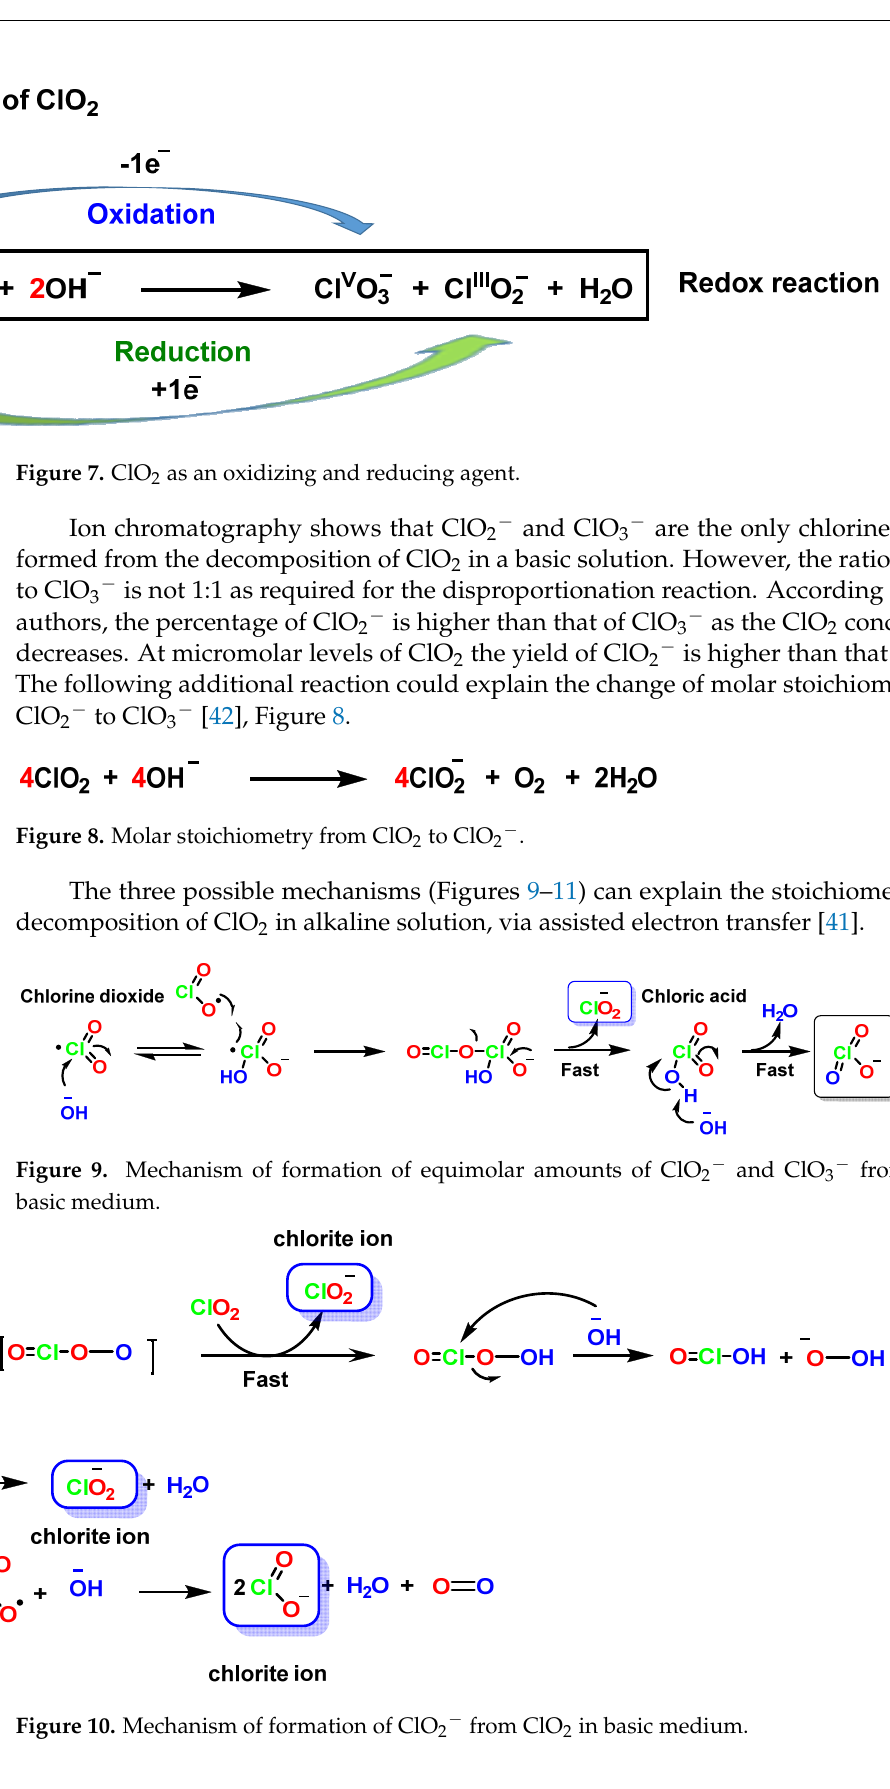
Figure 11. Mechanism of the formation of equimolar amounts of ClO 2 − and ClO 3 − from Cl 2 O 4 in basic medium. The distribution of chlorine dioxide decomposition products in a basic solution changes as the ClO 2 concentration decreases. While disproportionation reactions giving equal amounts of ClO 2 − and ClO 3 − dominate the stoichiometry at millimolar or higher ClO 2 levels, the ratio of ClO 2 − to ClO 3 − formed increases significantly at micromolar levels of ClO 2 [42]. The kinetic evidence shows three concurrent pathways that show a first order de ‐ pendence on [OH − ] but have a variable order on [ClO 2 ]. Pathway 1 is a disproportionation reaction that is first order in [ClO 2 ], Figure 12. Figure 12. First order disproportionation reaction in [ClO 2 ]. Pathway 2, a previously unknown reaction, is also first order in [ClO 2 ] but forms ClO 2 − as the only chlorine ‐ containing product. Pathway 2 is attributed to the attack of OH − on an oxygen atom of ClO 2 leading to intermediate peroxide intermediates and producing ClO 2 − and O 2 as products. This pathway is important at low levels of ClO 2 , Figure 13. Figure 13. Pathway 2 is also first order in [ClO 2 ] but forms ClO 2 − as the only chlorine ‐ containing product.